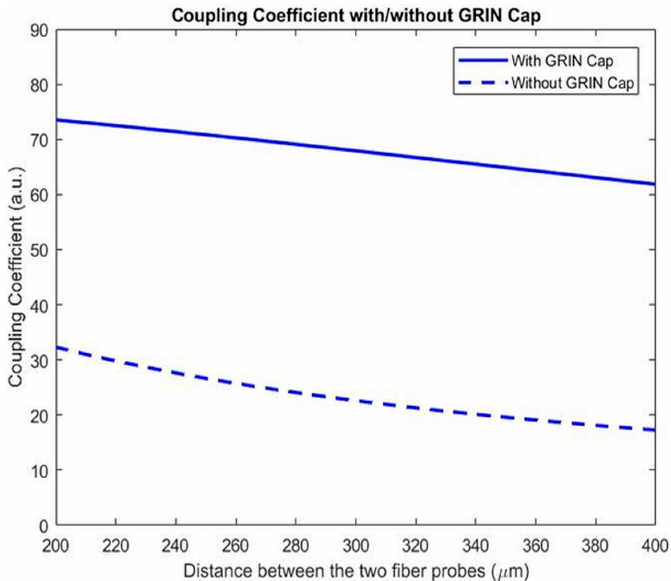
Figure 2. Coupling coefficient with and without GRIN caps spliced to the ends of single mode fibers. The single mode fiber and GRIN fiber’s parameters are from Newport F-SF single mode fiber and Thorlabs GIF-625 graded index fiber.